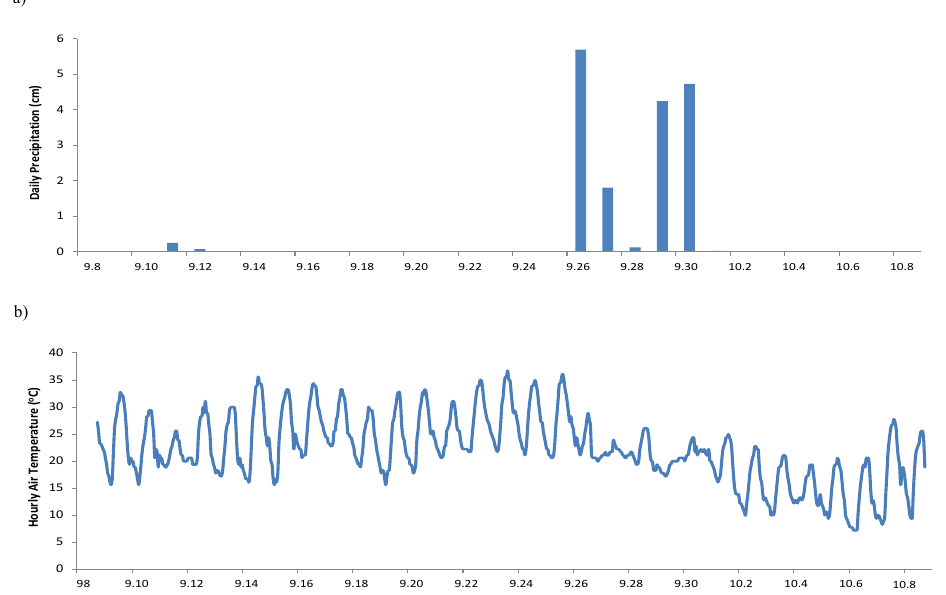
Figure 1. (a) Daily precipitation and (b) hourly air temperature at RDU airport ( ≈ 8km from sampling site) during the ETV period